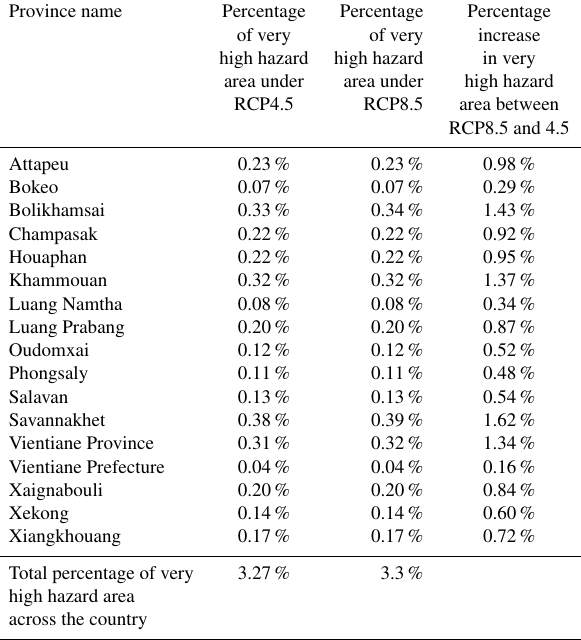
Table 3. Percentage of very high hazard area from the integrated hazard map in each province and the percentage of increase between the RCP8.5 and RCP4.5 scenarios during the near future. Province